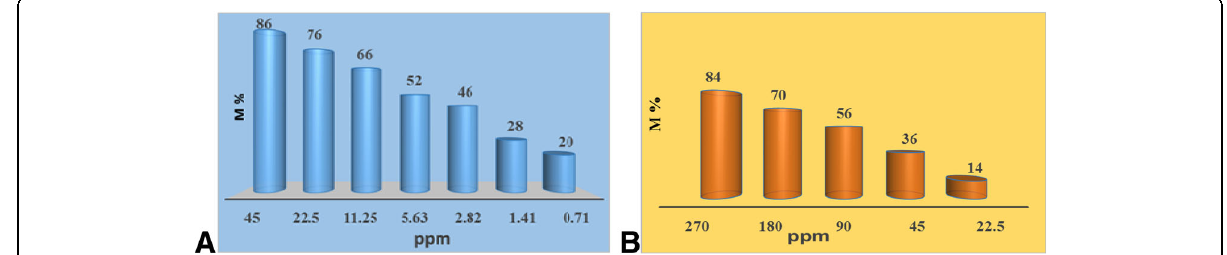
Fig. 5 The mortality percentages of second-instar larvae for profenofos to a laboratory and b field strains of Spodoptera